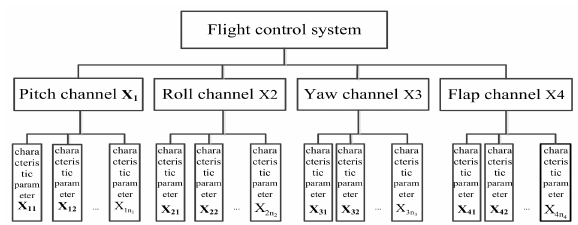
Figure 2. Flight control system characteristic